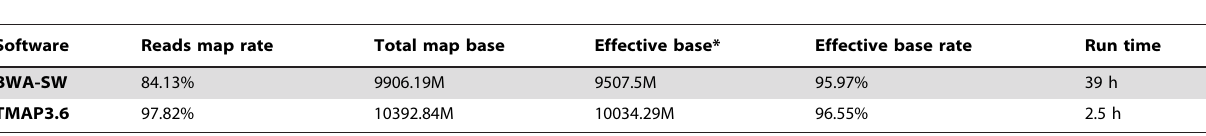
Table 1. Mapping results of the TP00005 library using BWA and TMAP.